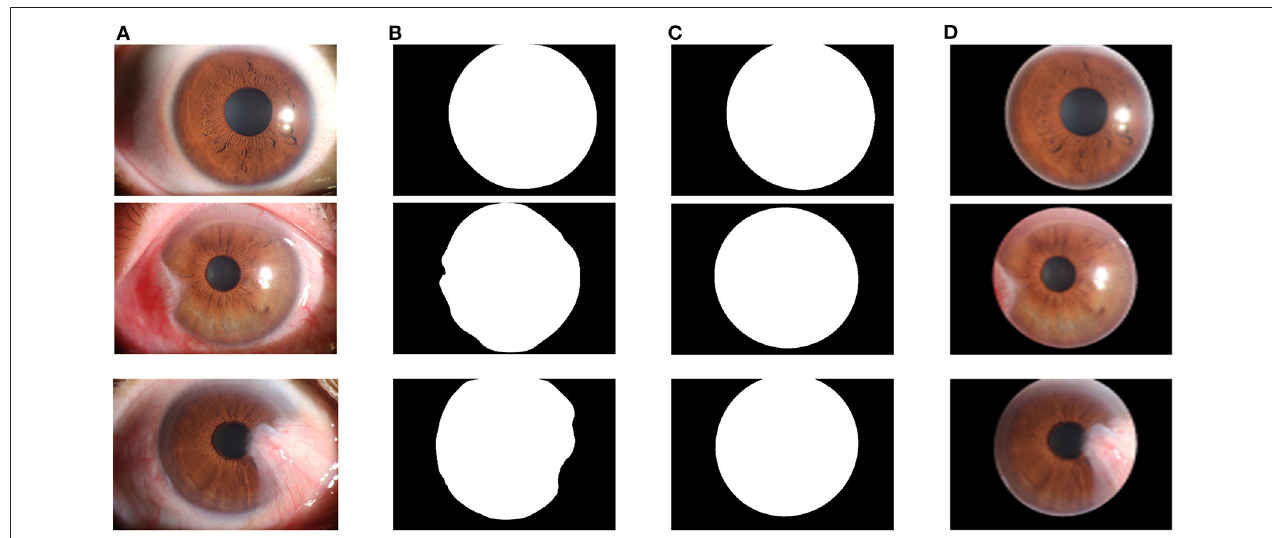
FIGURE 7 | Segmentation results of the cornea segmentation module: (A) Original anterior segment images. (B) Segmentation results of the trained U-Net model. (C) Output results with smooth edge after ellipse fitting. (D) Final cornea images output by the cornea segmentation module.